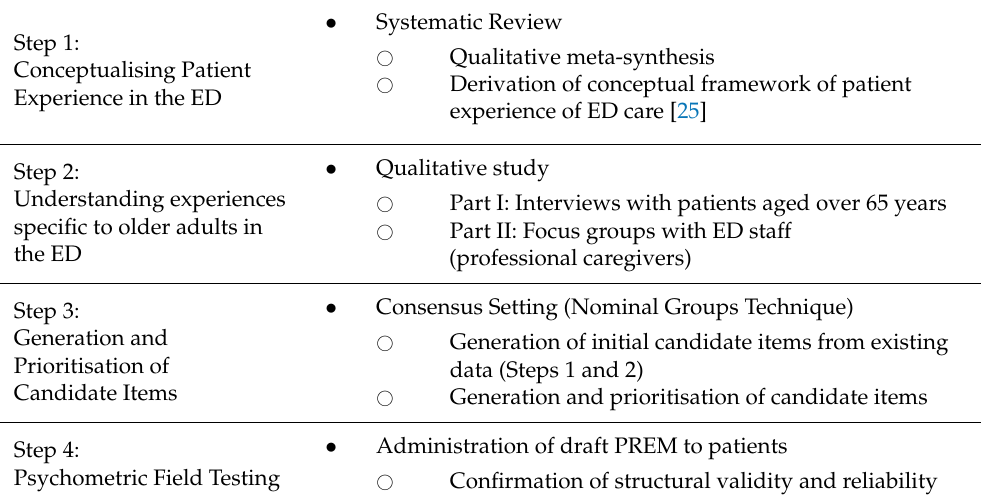
Table 1. Stepwise mixed methods approach to PREM ED 65+ development (note the current study is within step